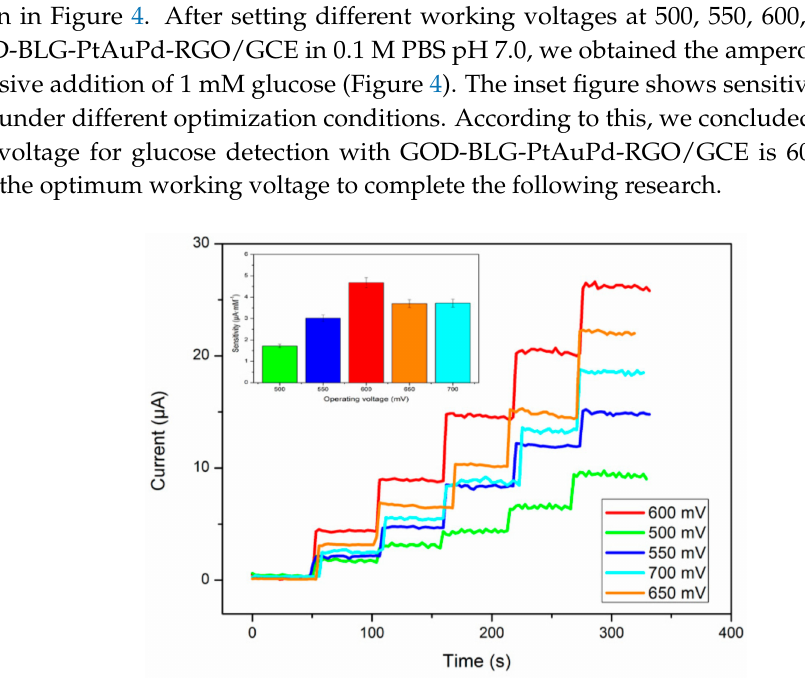
Figure 4. Amperometric response of GOD-BLG-PtAuPd-RGO/GC electrode upon successive additions of 1 mM glucose into 0.1 M PBS solution under stirring at operating voltage from 500 mV to 700 mV.